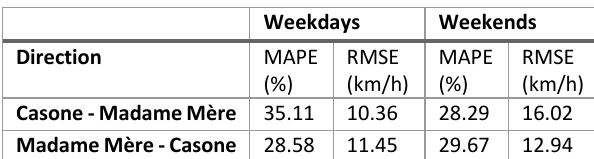
Table 4: A comparison of error rates on space-mean speeds from TomTom FCD compared to Bluetooth speeds on both driving Casone - Madame Mère towards the city and Madame Mère – Casone out of the city.